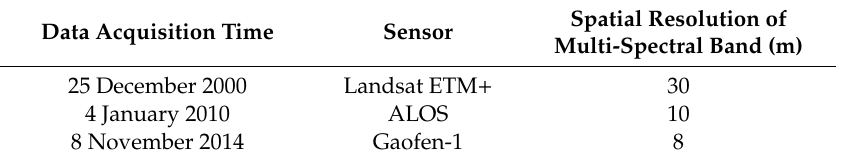
Table 1. Data source. ETM+: Landsat Enhanced Thematic Mapper Plus; ALOS: Advanced Land Observation Satellite.